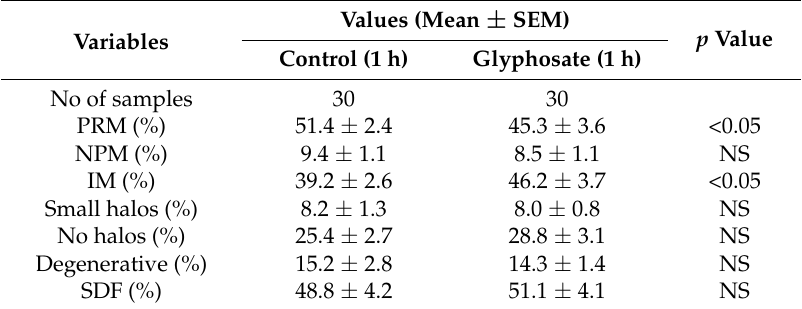
PRM: progressive motility; NPM: non-progressive motility; IM: immotility; SDF: sperm DNA fragmentation; NS: not significant.